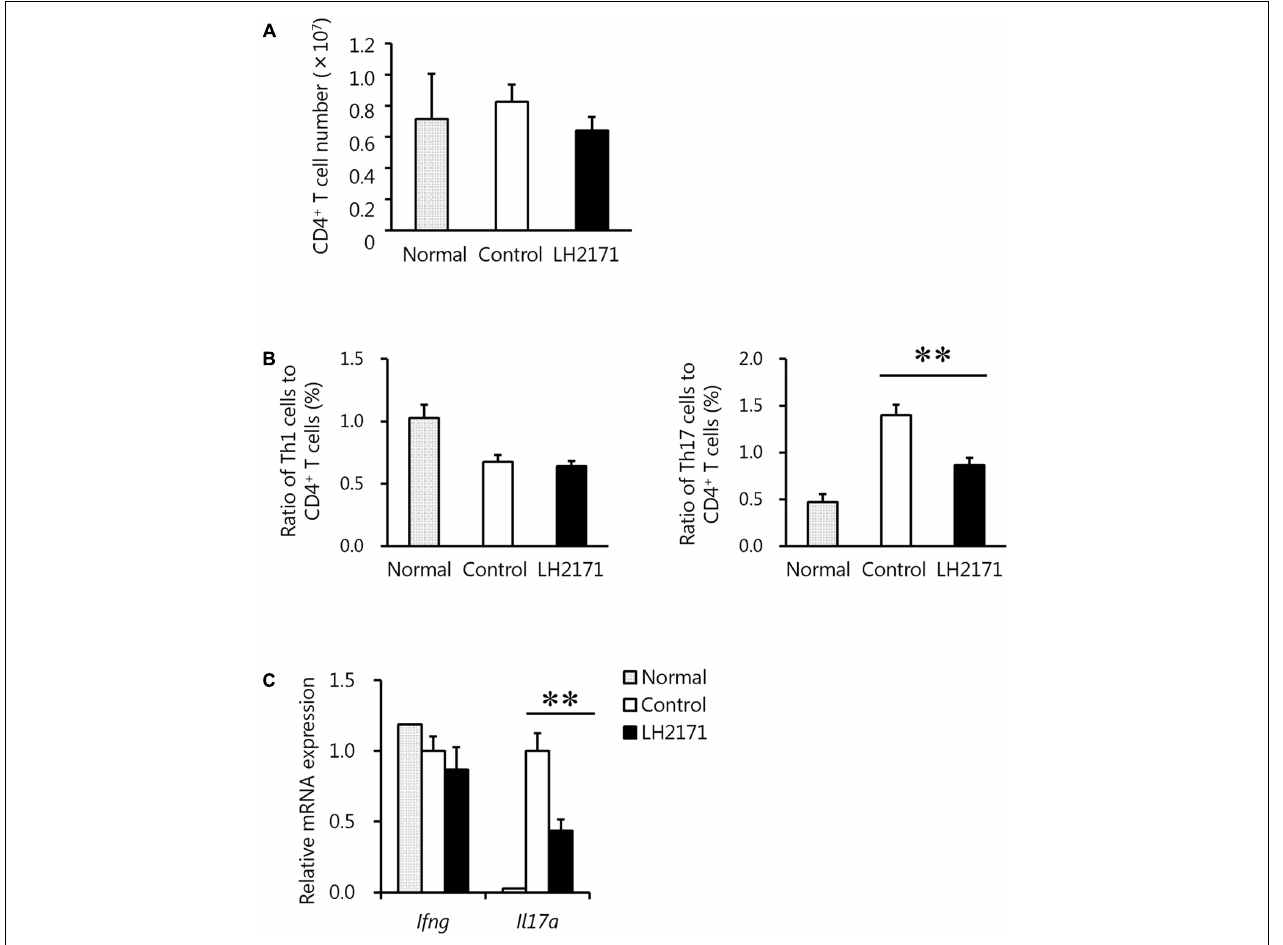
FIGURE 4 | Reduction of the Th17 cell population in the inguinal LNs by LH2171 administration before the onset of EAE. The inguinal LNs were collected from normal mice and EAE mice treated with or without LH2171 on day 7, before EAE onset. Immune cells isolated from the LNs were analyzed by flow cytometry, and the number of CD4 + T cells (A) and the ratio of Th1 or Th17 cells to CD4 + T cells (B) were determined. Expression levels of cytokine genes in immune cells from the LNs were determined by qRT-PCR (C) . Data are shown as a means ± SEM (normal group, n = 2; control group, n = 12; LH2171-treated group, n = 10). LH2171-treated mice were compared with control mice by Student’s t -test ( ∗∗ P <